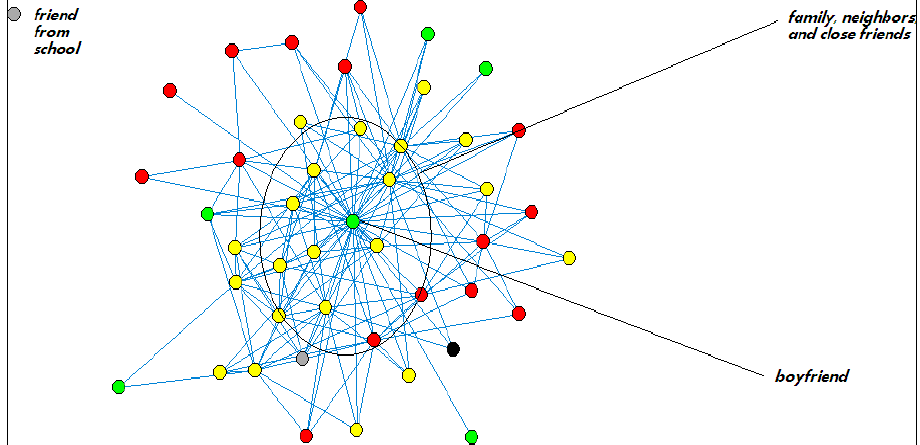
Note: Members of her network hailed from the US (red), the Dominican Republic (yellow), Puerto Rico (green) and others (black and grey). Reflective of her social environment, she reported using the following ethnic identifications: Latina, Dominicana, Hispana, Cibaeña, Capitaleña, Caribeña, Morenita, Dominicana- Americana, Española,